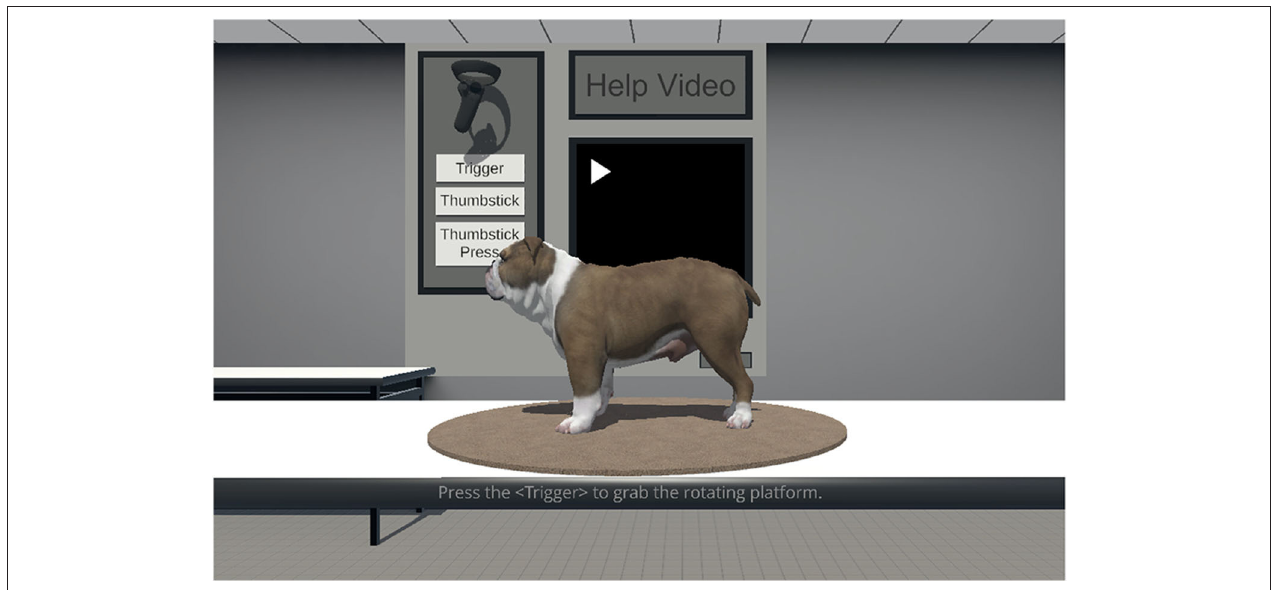
FIGURE 1 | The reality-based interface at the start of the interaction. Help systems are embedded within the